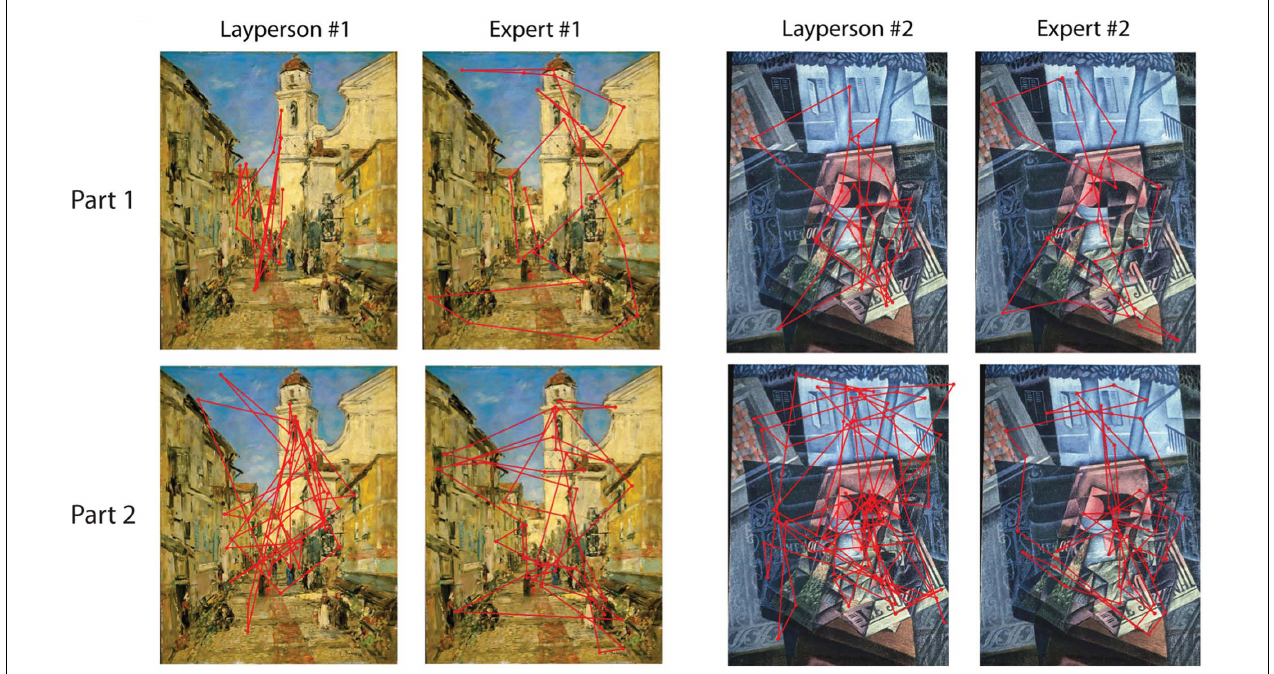
views the picture more widely.This difference is not seen between the layperson #2 and expert #2 for Gris’ painting, thereby illustrating the large variability between subjects and/or paintings. In Part 2 the differences between laypersons and experts tend to